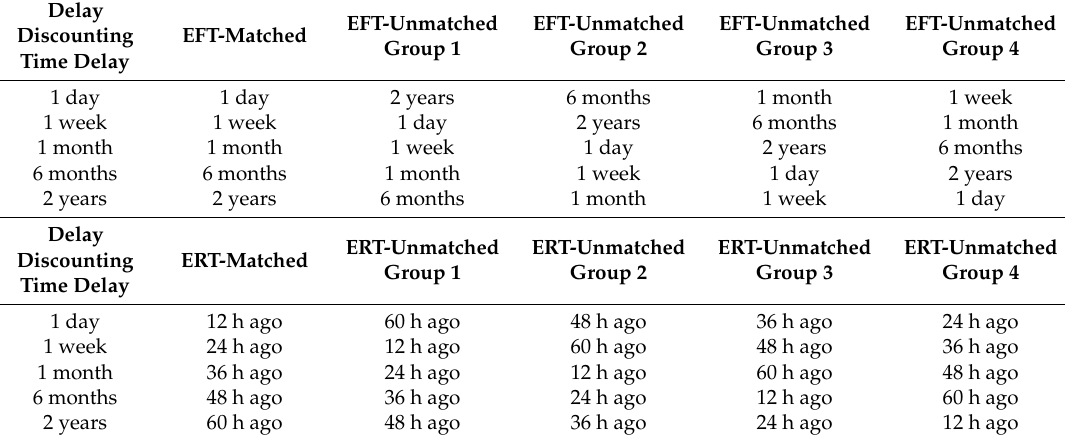
Table 1. Cue presentation for episodic future thinking (EFT) and episodic recent thinking (ERT) groups depending on